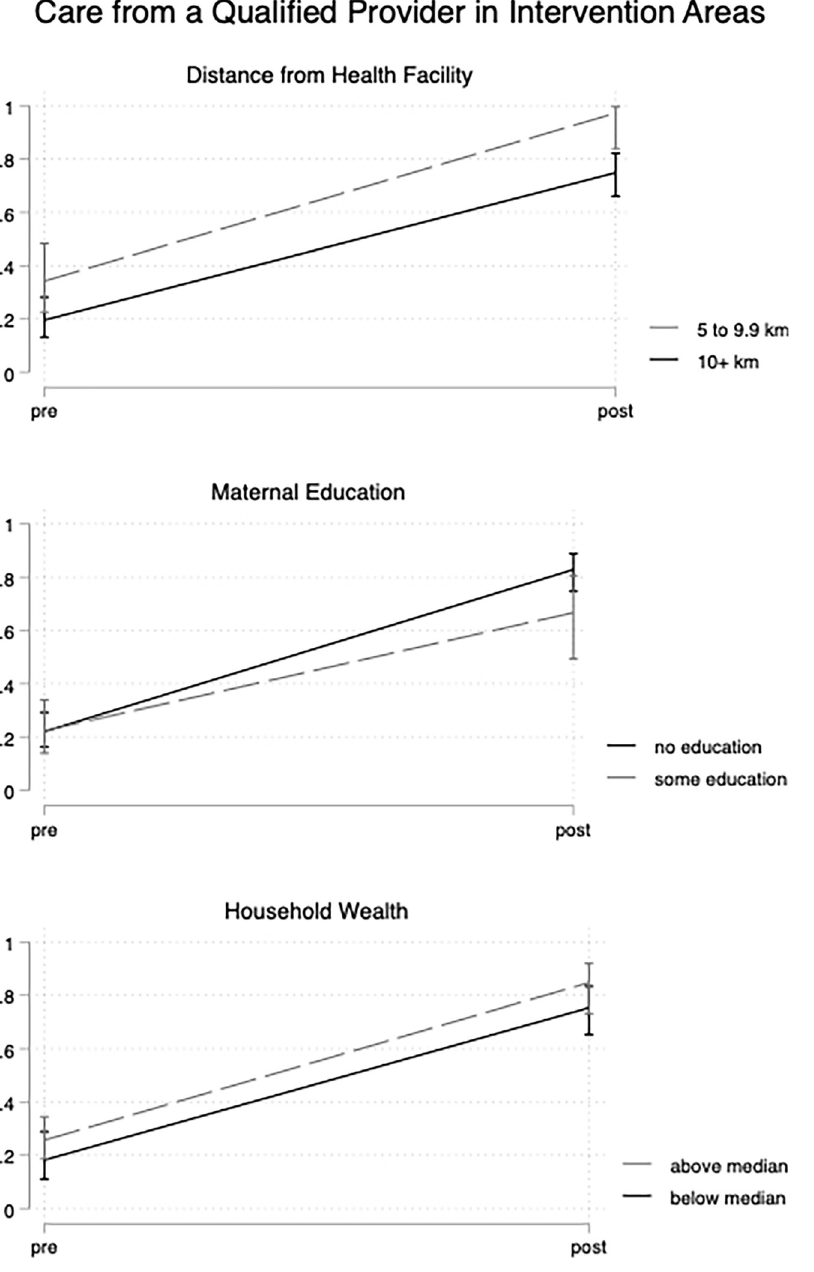
Fig 3. Improvements in childhood illness care by key dimensions of equity in implementation